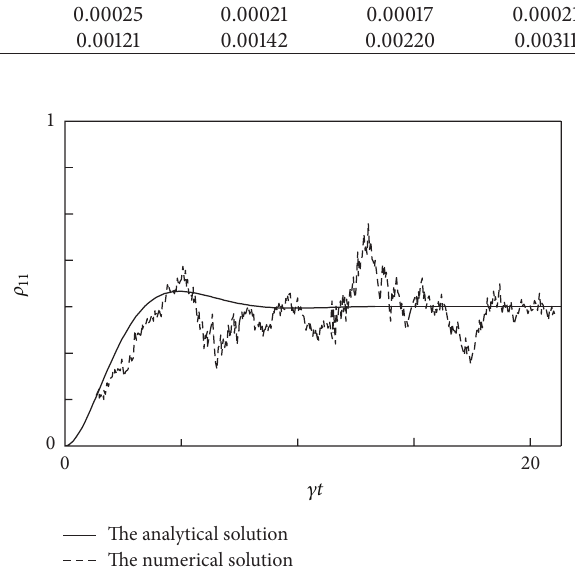
Figure1:Thecomparisonbetweenthenumericalsolutionof 𝜌 11 and the analytical solution direct photodetection of a driven two-level system with the parameters: Δ𝑡 = 0.01 , Ω = 0.45 , and 𝛾 = 0.3